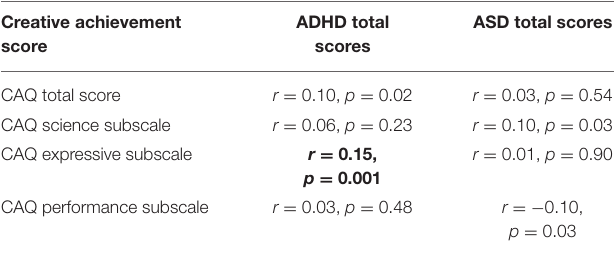
TABLE 5 | Correlations of ADHD and ASD total scores with creative achievement scores in the BIG study (population-based